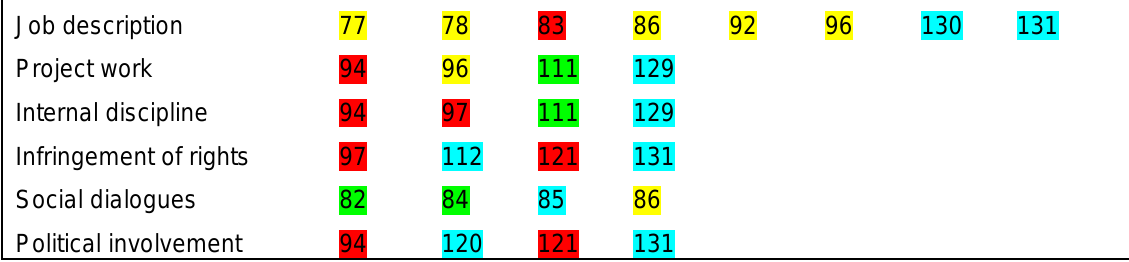
Table 5 List of outliers in the